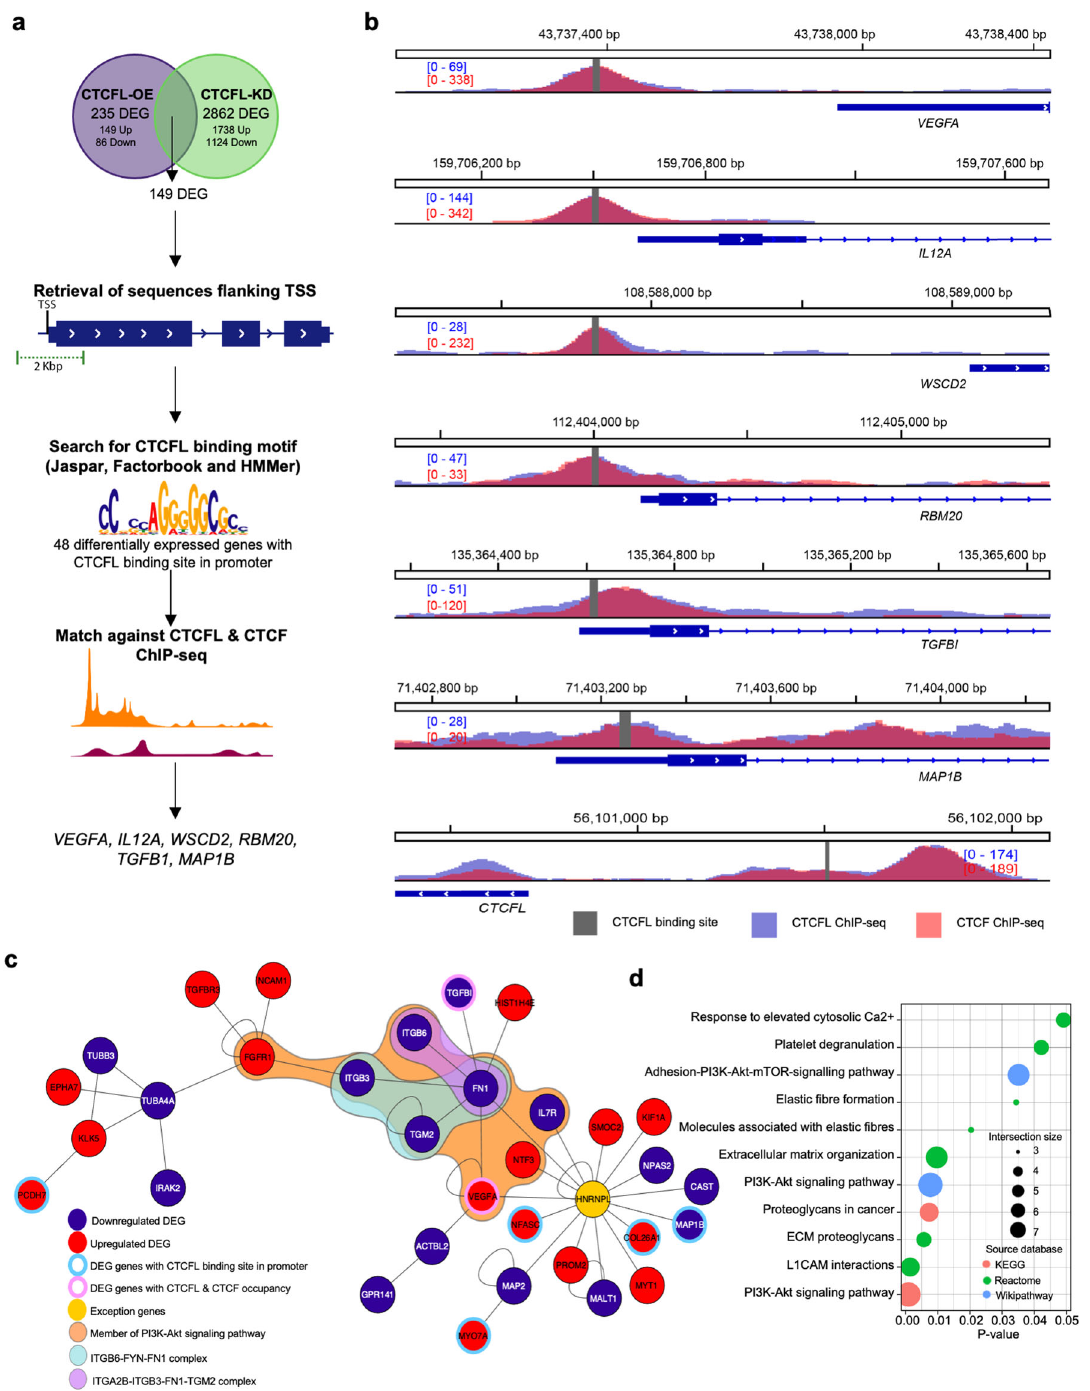
Fig. 2 Identi fi cation of CTCFL direct targets and CTCFL-deregulated protein interaction network. a Schematic representation of the work fl ow followed for the identi fi cation of DEGs with CTCFL BS. Sequences fl anking the TSS of DEGs found in both experimental conditions were retrieved and used as input for motif identi fi cation with HMMer using the reported CTCFL motifs in Jaspar and Factorbook. Next, genes with a predicted BS and experimentally validated CTCFL and CTCF occupancy (ChIP-seq) were selected. b Visual representation of CTCFL and CTCF occupancy in predicted CTCFL BSs of the genes VEGFA, IL12A, WSCD2, RBM20, TGFB1, MAP1B , and CTCFL . c Protein interaction network enriched with CTCFL-deregulated genes found in vitro. d Functional enrichment analysis of genes in the protein interaction network using KEGG, Reactome, and Wikipathway its therapeutic potential remains to be explored and it could be a be a key connector gene in the CTCFL-DEG-enriched network, it good candidate for drug development. Together, these results participates in the PI3K-Akt pathway and it is differentially provide mechanistic insights into ovarian cancer-associated expressed in OC patients. Despite the importance as a prognostic transcriptional changes while also being potential markers of marker of MALT1 , no approved targeting drugs were found; thus,